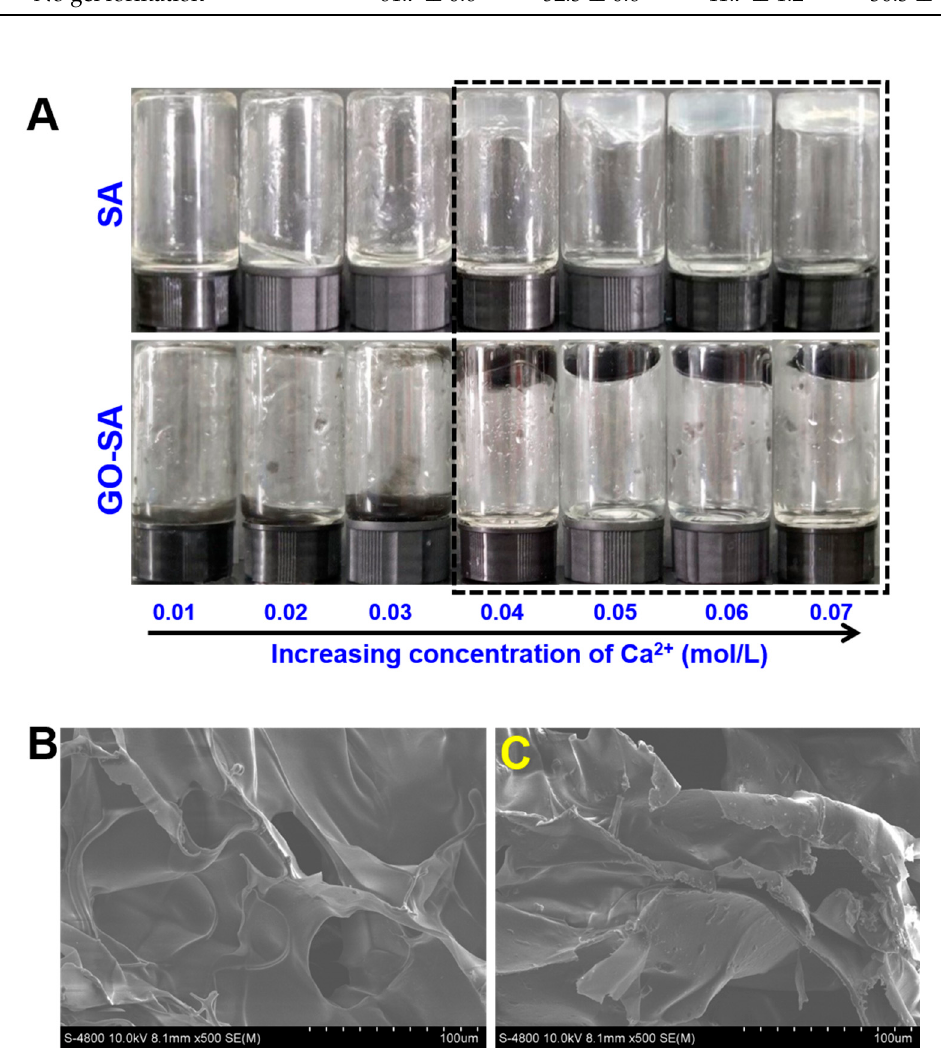
Figure 3. ( A ) Macroscopic images of hydrogel development. The experiment was conducted with blank SA hydrogel and GO-SA hydrogel. Both hydrogel systems commenced forming hydrogel at the feeding concentration of crosslinker of 0.04 mol/L, which zoning within a dotted area. SEM images of ( B ) SA and ( C ) GO-SA hydrogels.